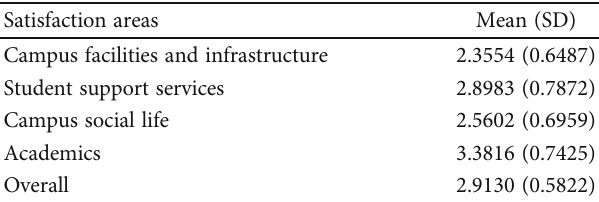
Table 2: Mean satisfaction